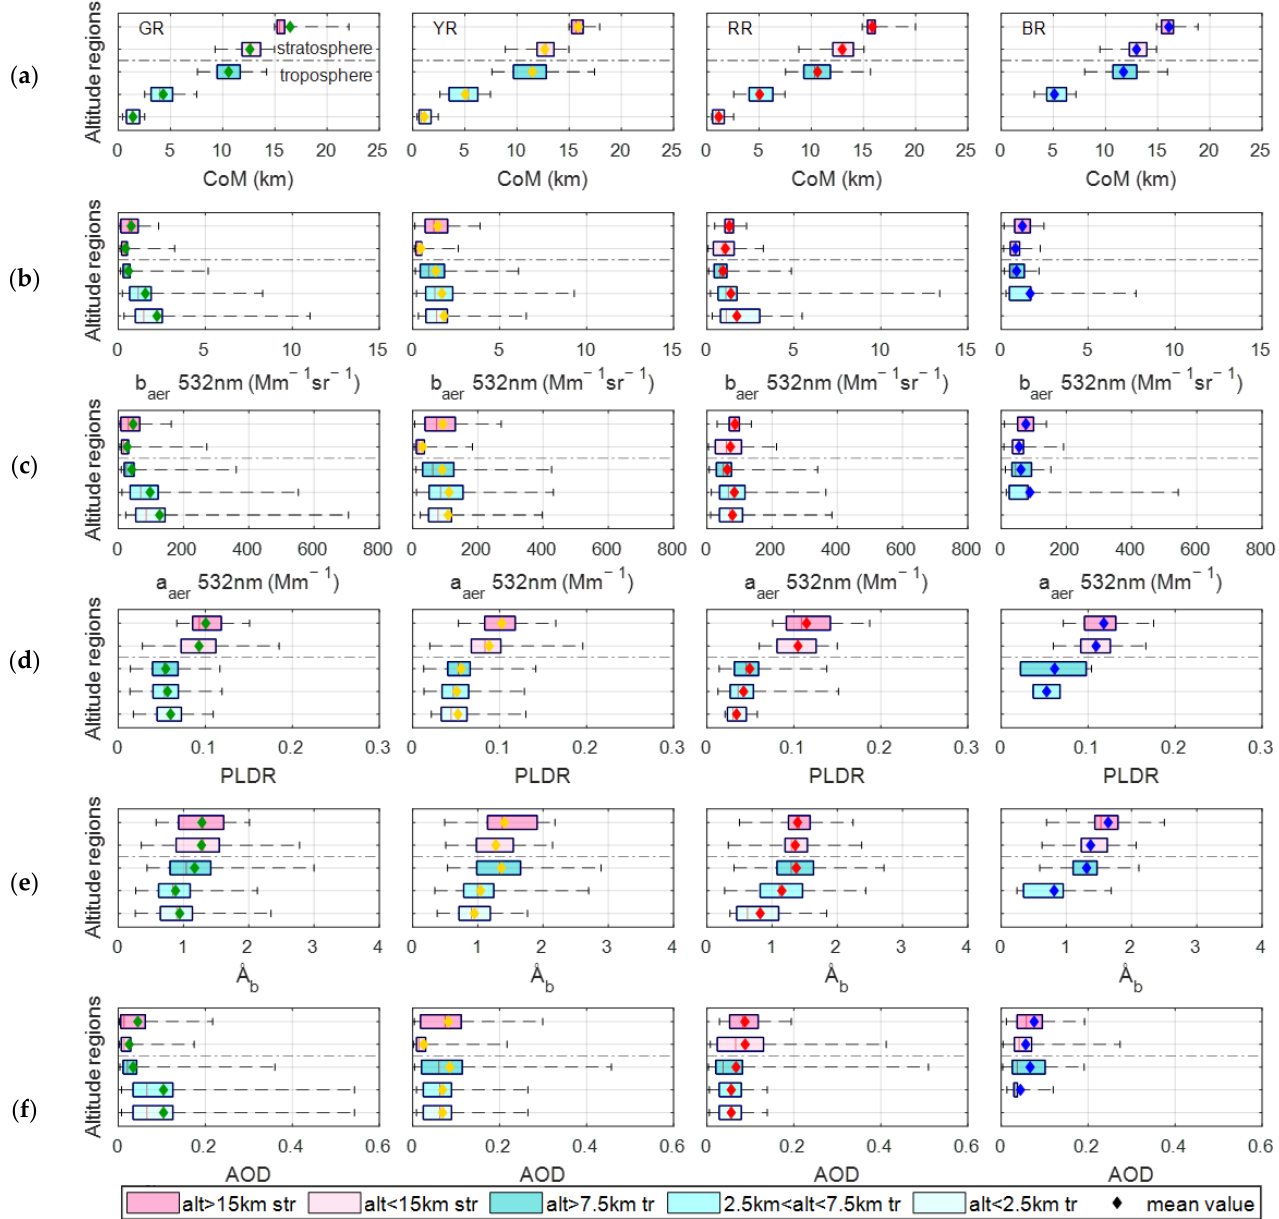
Figure 5. BB aerosol layers according to ( a ) their CoM (amsl.), ( b ) b aer , ( c ) a aer , ( d ) PLDR at 532 nm, ( e ) Å b (532/1064 nm), and ( f ) AOD at 532 nm. GR, YR, RR, and BR (left to right) correspond to the four under-study regions, while the different colors indicate the different height-range categories.